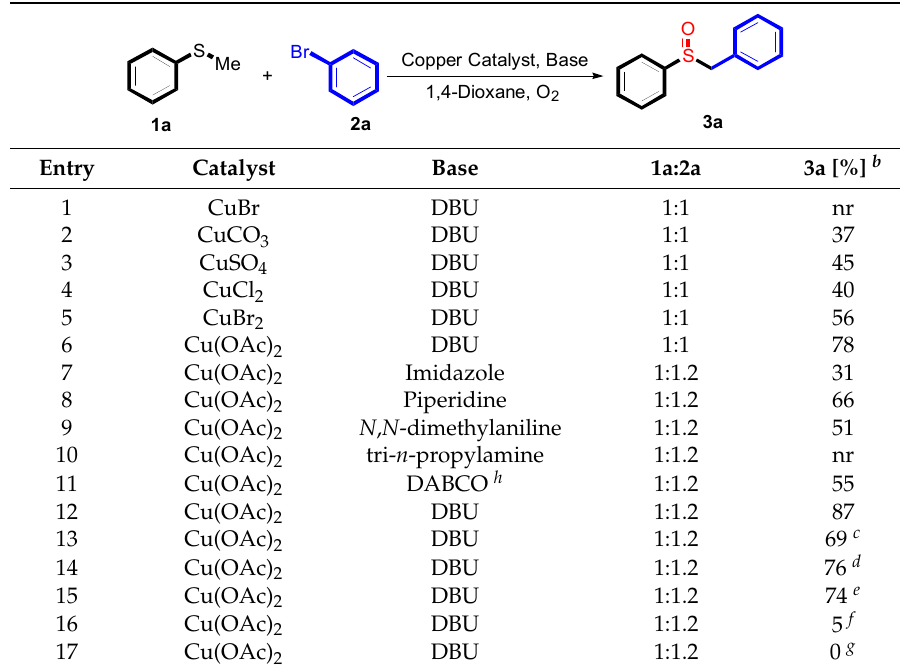
Table 1. Optimization of the reaction conditions a .